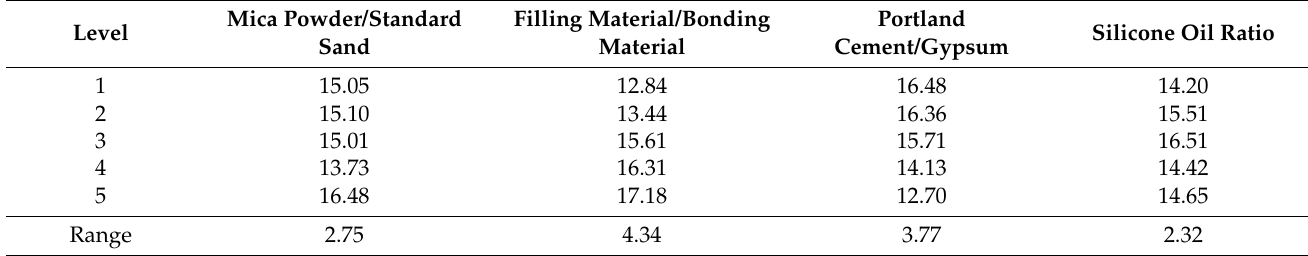
Table 6. Range analysis of density %.